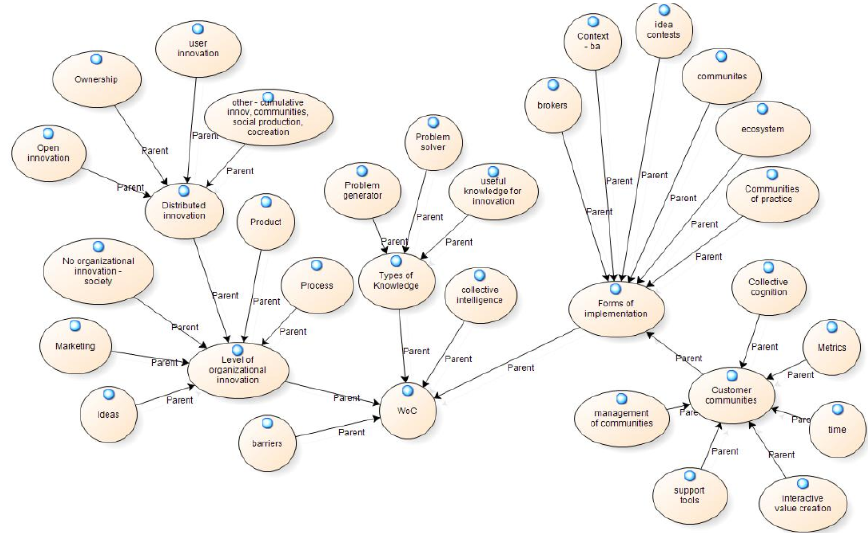
Fig. 5. Overview of Crowdsourcing: Exploratory